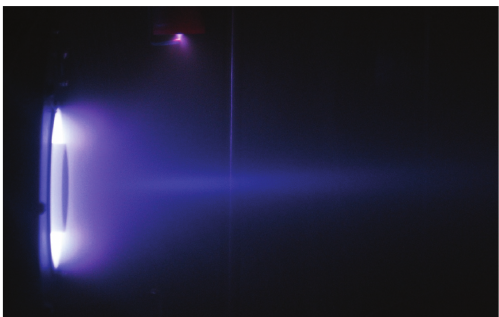
Figure 2: ATON A-3 running with krypton.